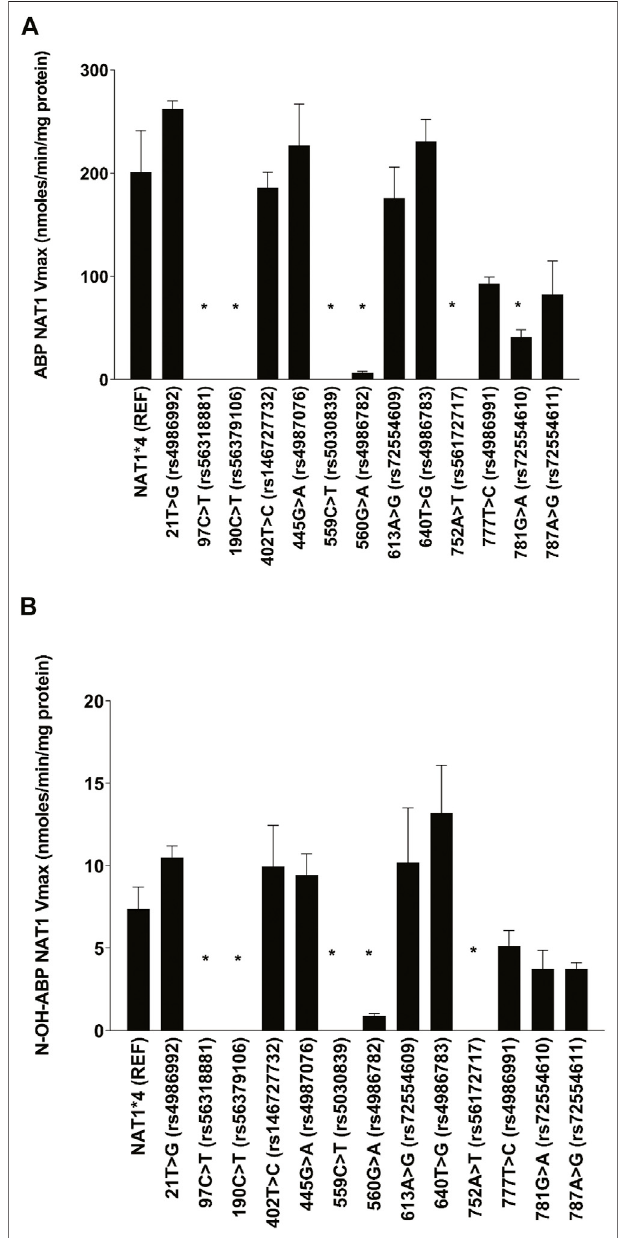
FIGURE 2 | Apparent Km for (A) ABP and (B) N-OH-ABP for NAT1*4 (reference) and NAT1 variants possessing the SNP labeled on the abscissa. Each bar represents Mean ± SEM from three transfections in duplicate. *Signi fi cantly less than NAT1*4 for ABP ( p < 0.05) and N-OH-ABP ( p <